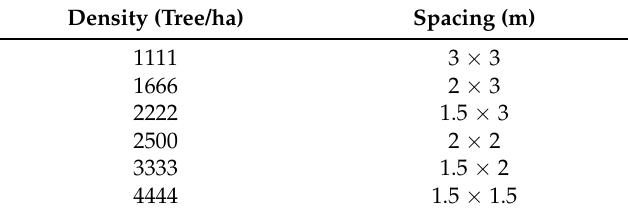
Table 1. Jack pine plantation densities used for the experiment and their corresponding